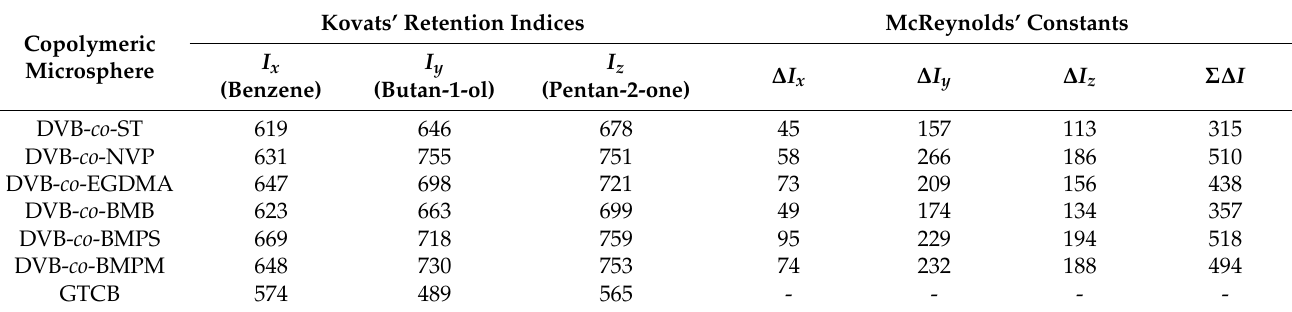
Table 6. Kovats’ retention indices for the McReynolds’ test substances and overall polarity ( Σ∆ I ) for the porous copoly- meric